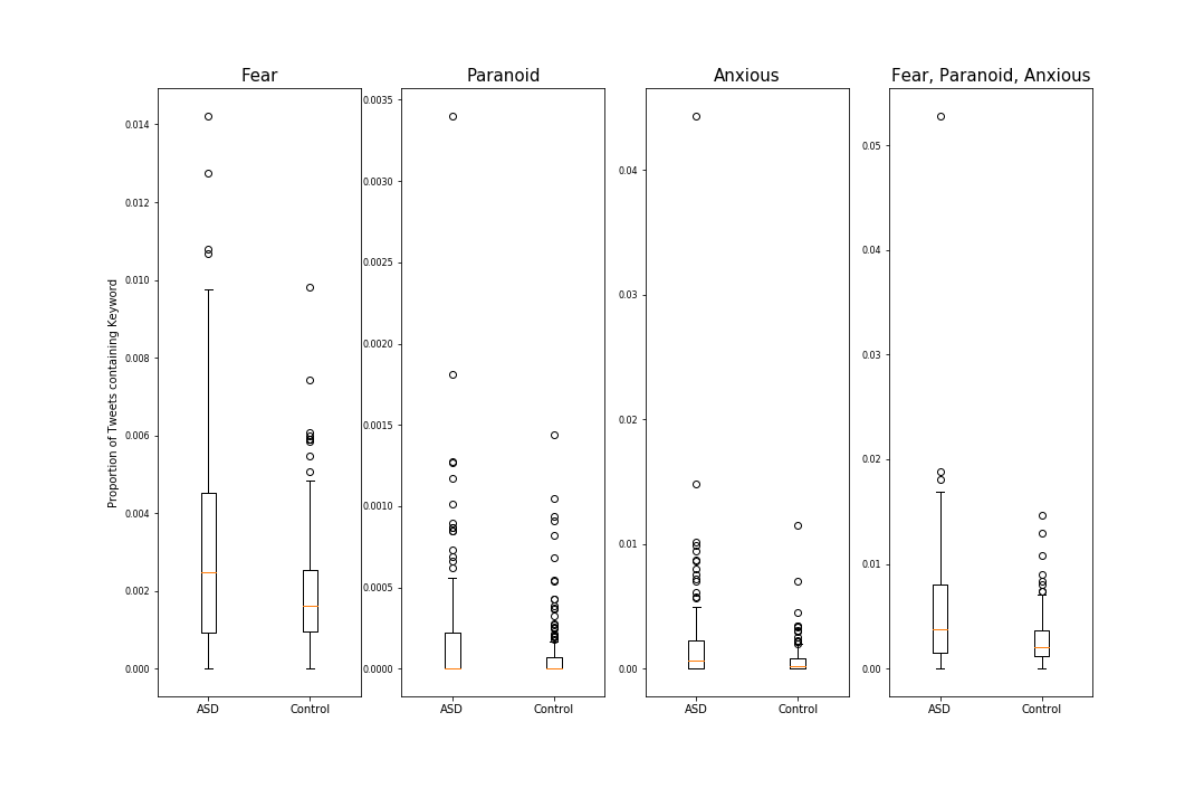
Figure 1. Differences in emotions between autism spectrum disorder (ASD) and control users.